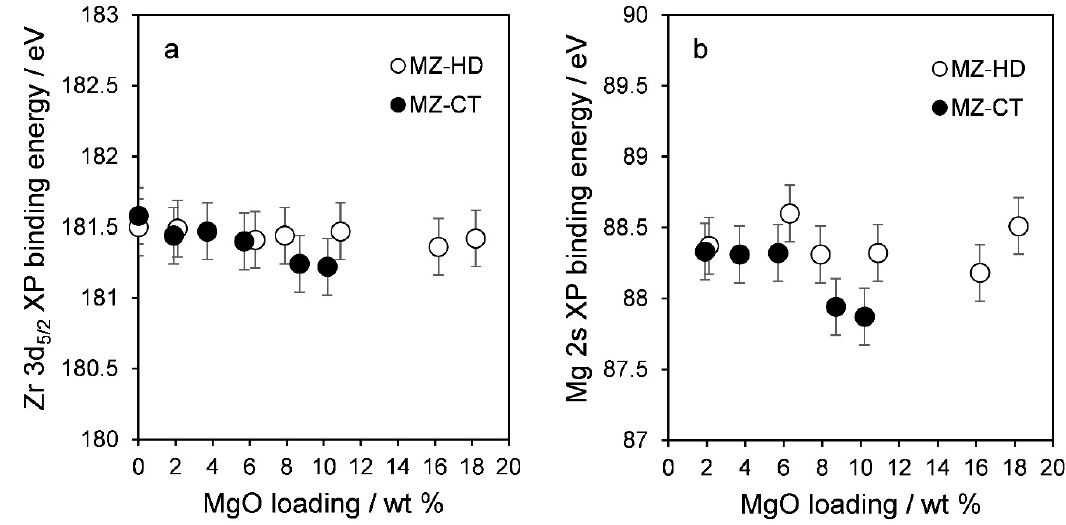
Figure 3. ( a ) Zr 3d; and ( b ) Mg 2s XP binding energies for xMZ–HD and xMZ–CT mixed oxides and corresponding pure zirconias.